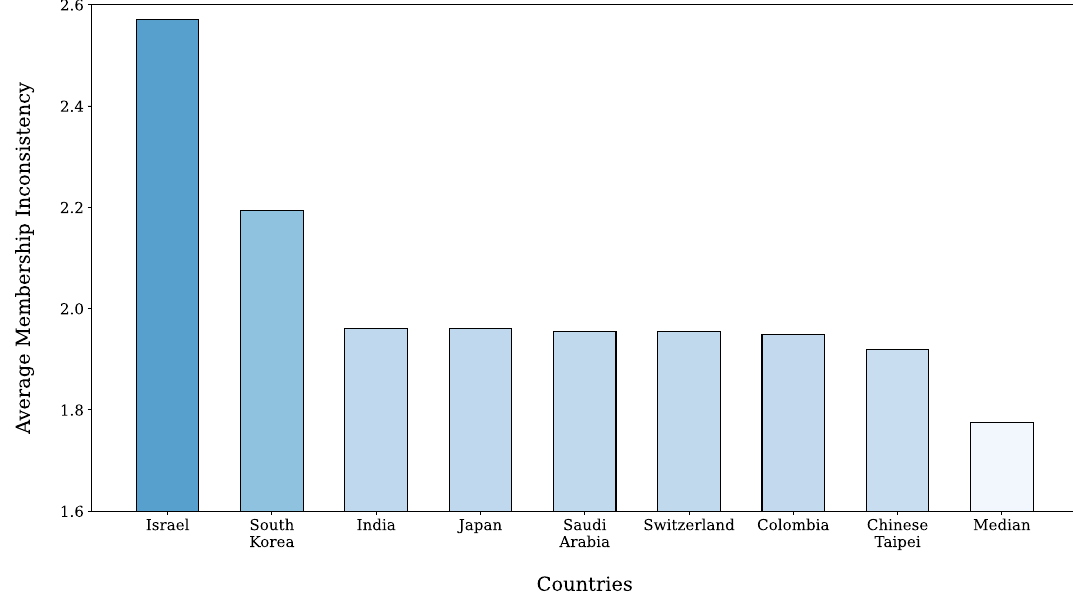
Figure 5. The bar chart of the average membership inconsistency (MeI) of the eight countries with the highest MeI. The MeI is averaged for the period 2010–2019. The bars of the countries with higher average MeI are colored in darker blue.